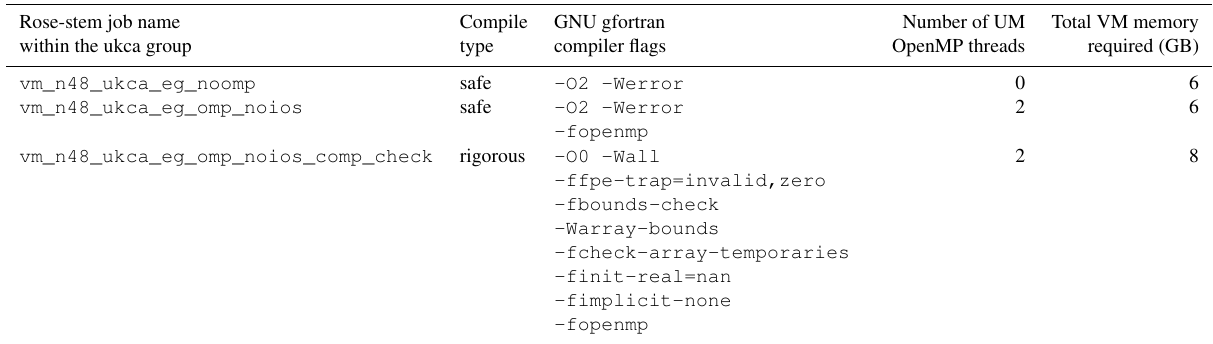
Table 3. UKCA rose-stem jobs available on the VM, showing the differences between Fortran compiler flags used for safe and rigorous compile options. C flags also differ. Both safe jobs point to the same KGO files.